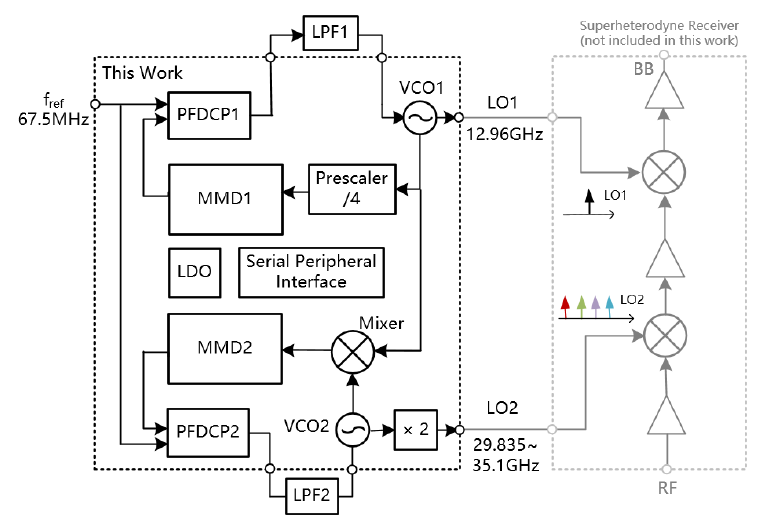
Figure 3. Block diagram of the proposed dual-loop dual-output frequency synthesizer for Block diagram of the proposed dual-loop dual-output frequency synthesizer for IEEE802.11aj (45 GHz) standard. IEEE802.11aj (45 GHz)